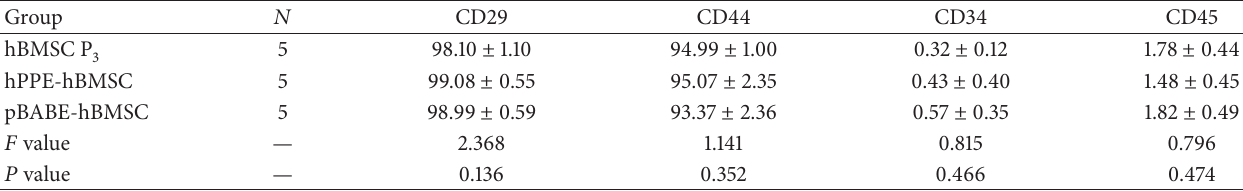
Table 1: Analysis of cell surface marker expression by flow cytometry after transfection (%, 𝑋 ± SD). Group 𝑁 CD29